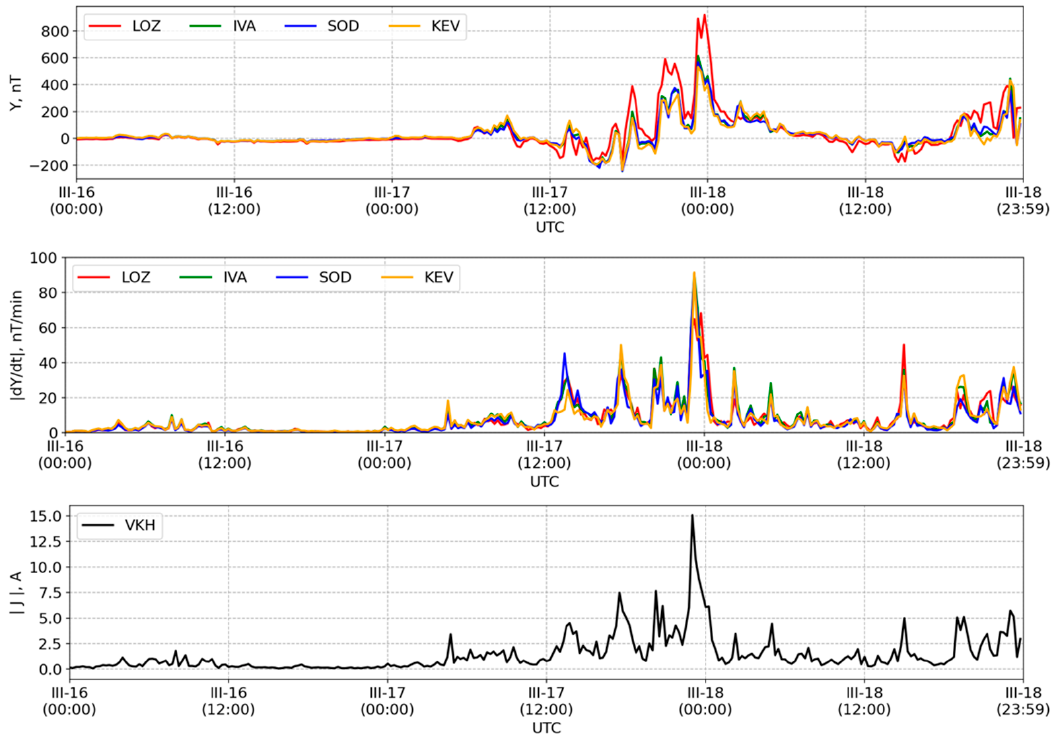
Figure 2. A fragment of the time series (averaged over 15-min intervals) of the initial data, comprising the magnetic storm on 17 March 2015. In the time series of the Y component of the geomagnetic variations, the baseline has been excluded.